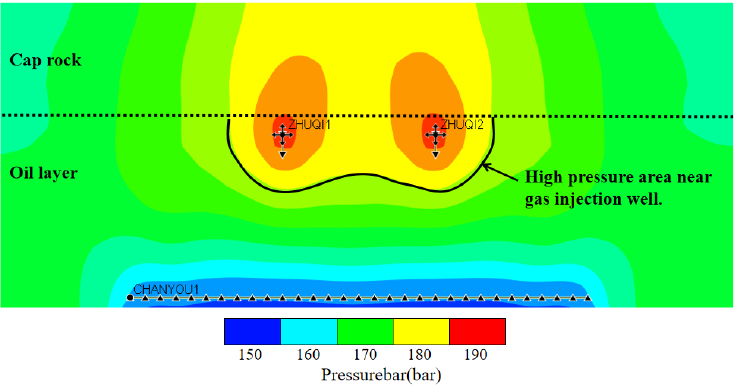
Figure 7. Case 1 pressure distribution in the fifth year of operation.